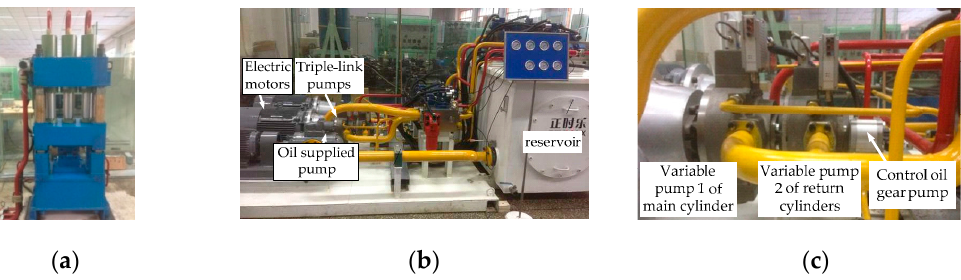
Figure 11. The test-bed diagram. ( a ) Hydraulic press body; ( b ) Hydraulic system of the press; ( c ) MOOG’s triple-link pumps.